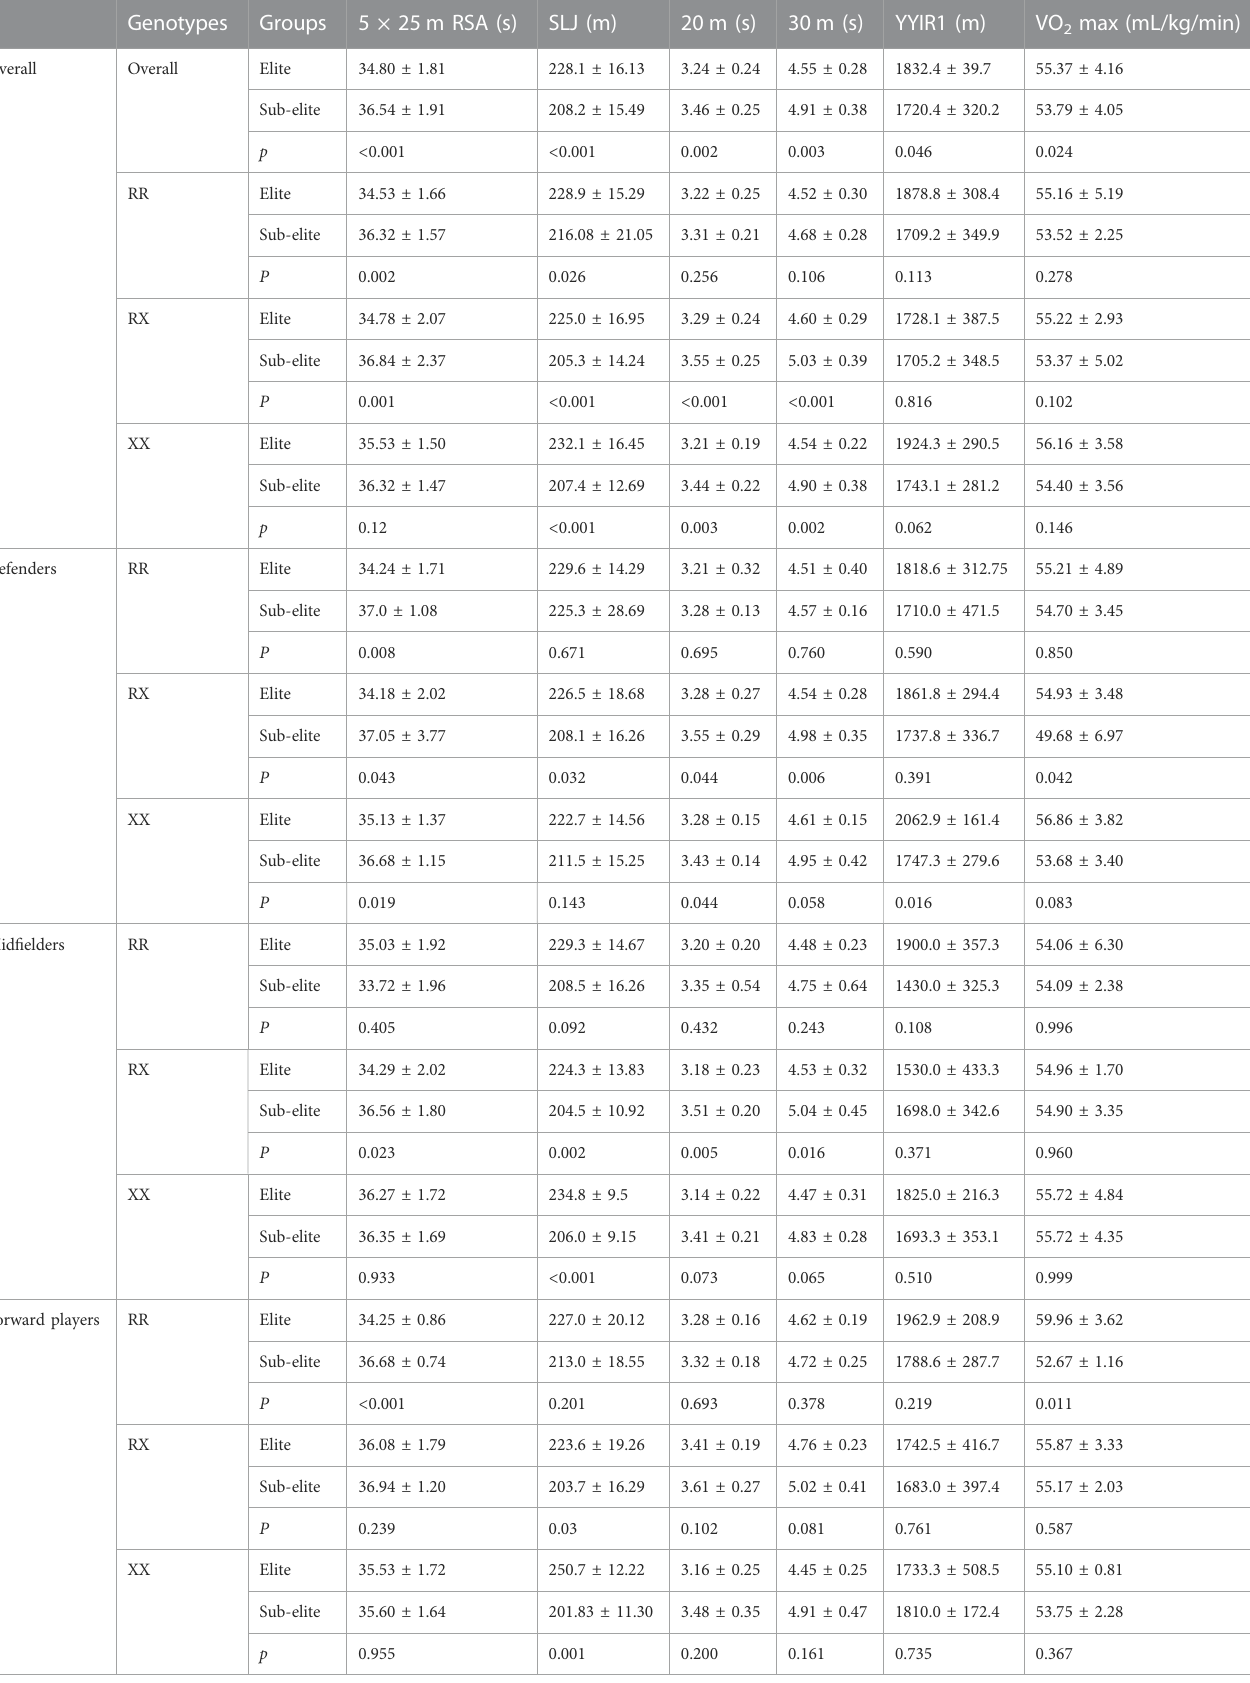
TABLE 5 Comparison of RR, RX and XX of athletic performance in elite and sub-elite